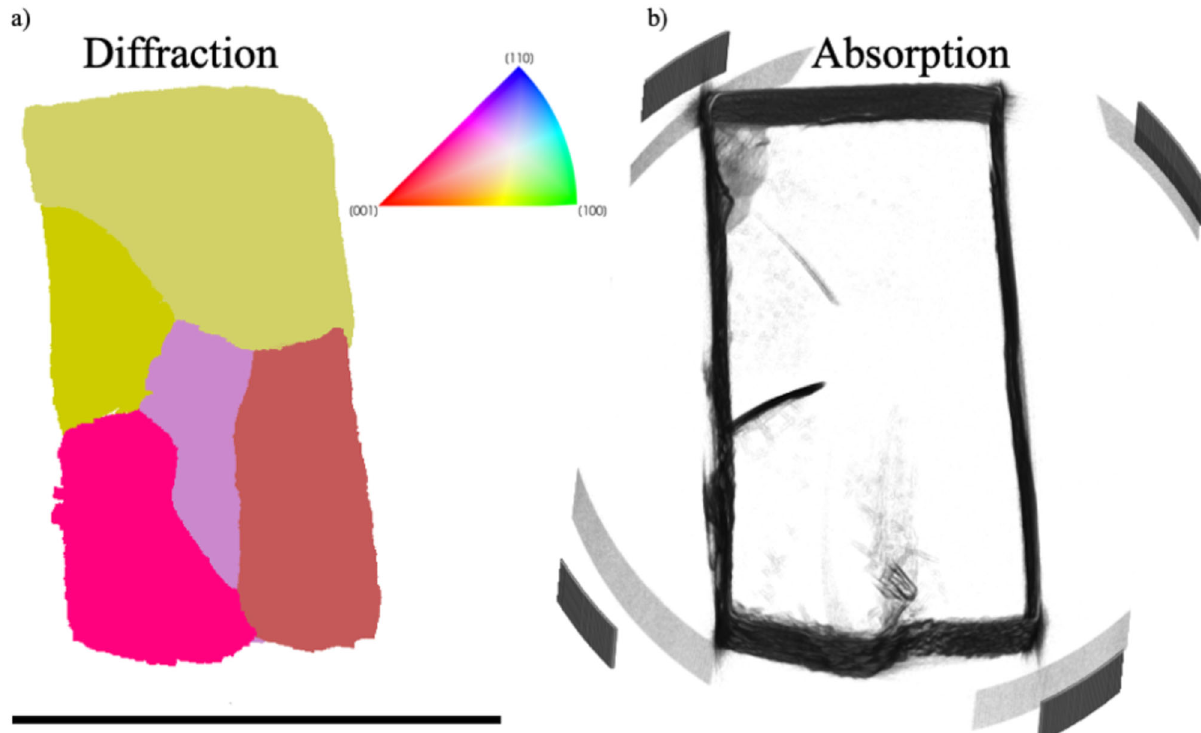
Fig. 6 Grain boundaries in r-TiO 2 . Floating zone-grown rutile TiO 2 is visualized in both ( a ) diffraction CT and ( b ) absorption CT data. Multiple crystalline domains are present in the sample, as is expected for an early-stage portion of the growth. The absorption data shown has had a Sobel fi lter applied to highlight the edges.